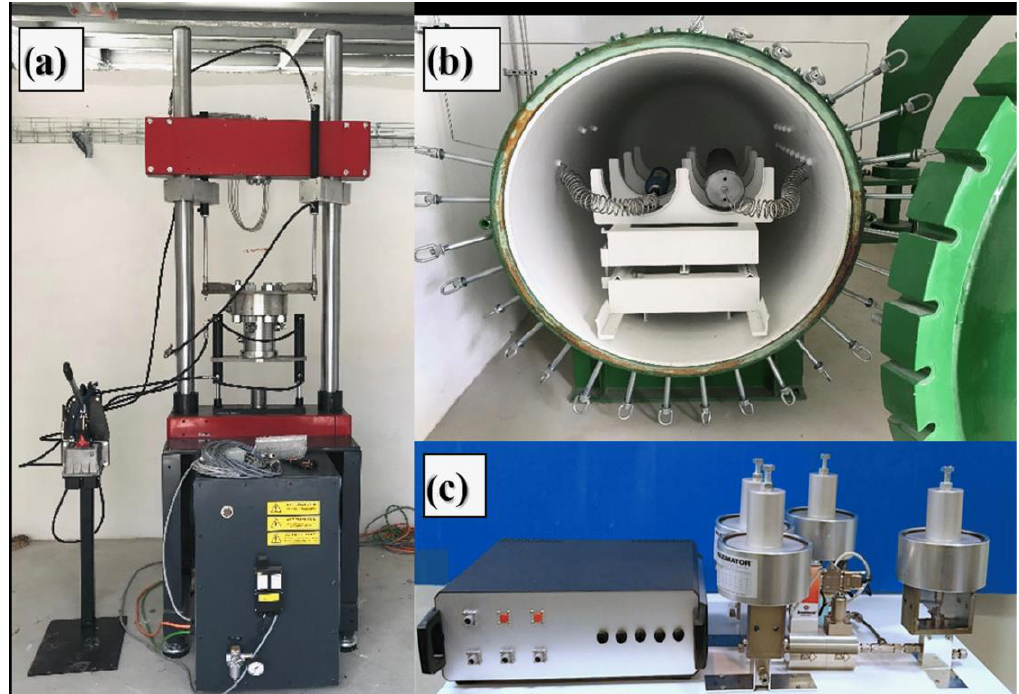
Figure 2. Δ H Lab test: ( a ) Servo-hydraulic machine for small scale tests, ( b ) Inert security chamber for full scale tests, and ( c ) High-Pressure-Concentration-temperature (HPCT) for adsorption tests.